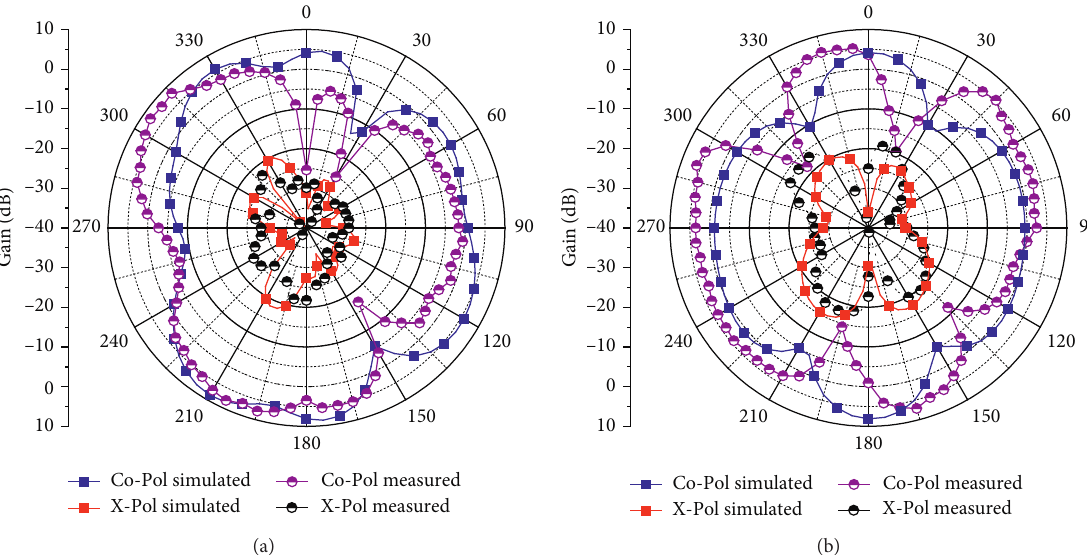
Figure 9: Simulated and tested normalized patterns. (a) E-Plane (XoZ) Co-X polarization at 9.9GHz. (b) H-plane (YoZ) Co-X polarization at 9.9GHz.